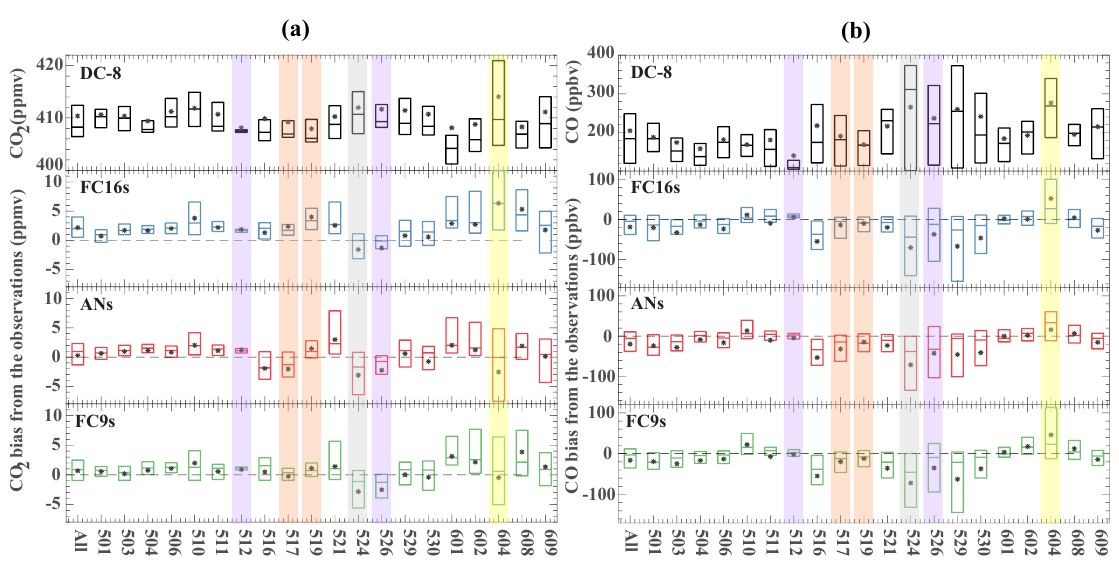
Figure 2. Box plot for each individual flight. The flight date (MDD) for each box plot is indicated in the bottom x axis. Note that the dates here are in UTC time instead of South Korean time. Panel (a) is for CO 2 and panel (b) is for CO. The first row corresponds to the box plot of the abundances measured by DC-8 aircraft. The second, third, and fourth rows correspond to the box plot of the bias of FC16s, ANs, and FC9s relative to the DC-8 aircraft data, respectively. The purple shade marks the flights with frontal passage, and orange shade marks the flights that may possibly be affected by biomass burning. The grey shade marks the flight measuring China outflow while yellow shade marks the flight surveying point emission sources.